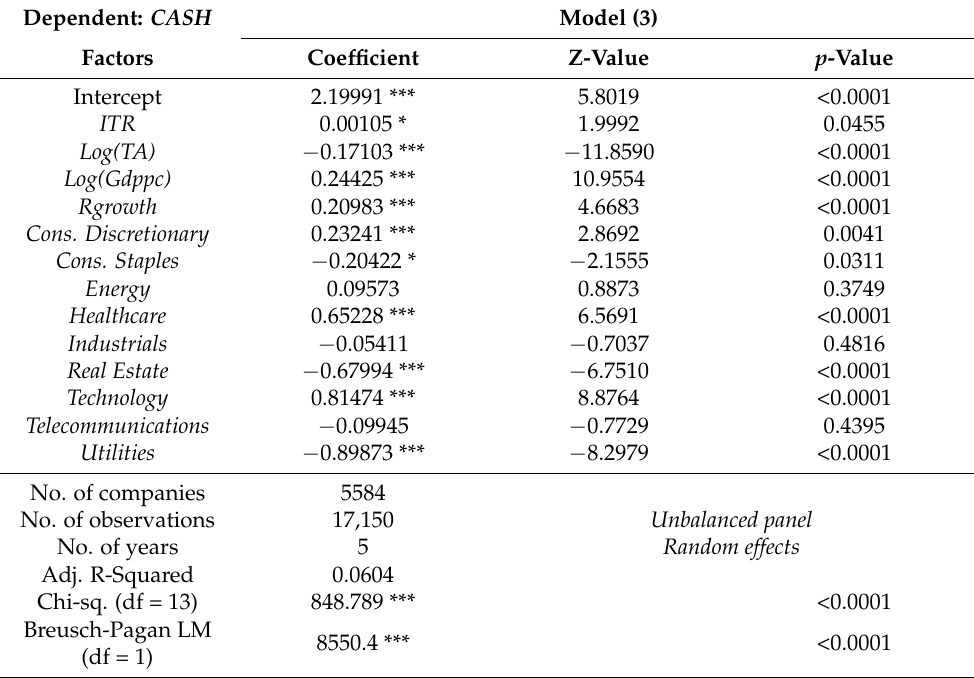
Table 8. Panel regression results for the natural logarithm of the cash ratio ( CASH ) as the dependent